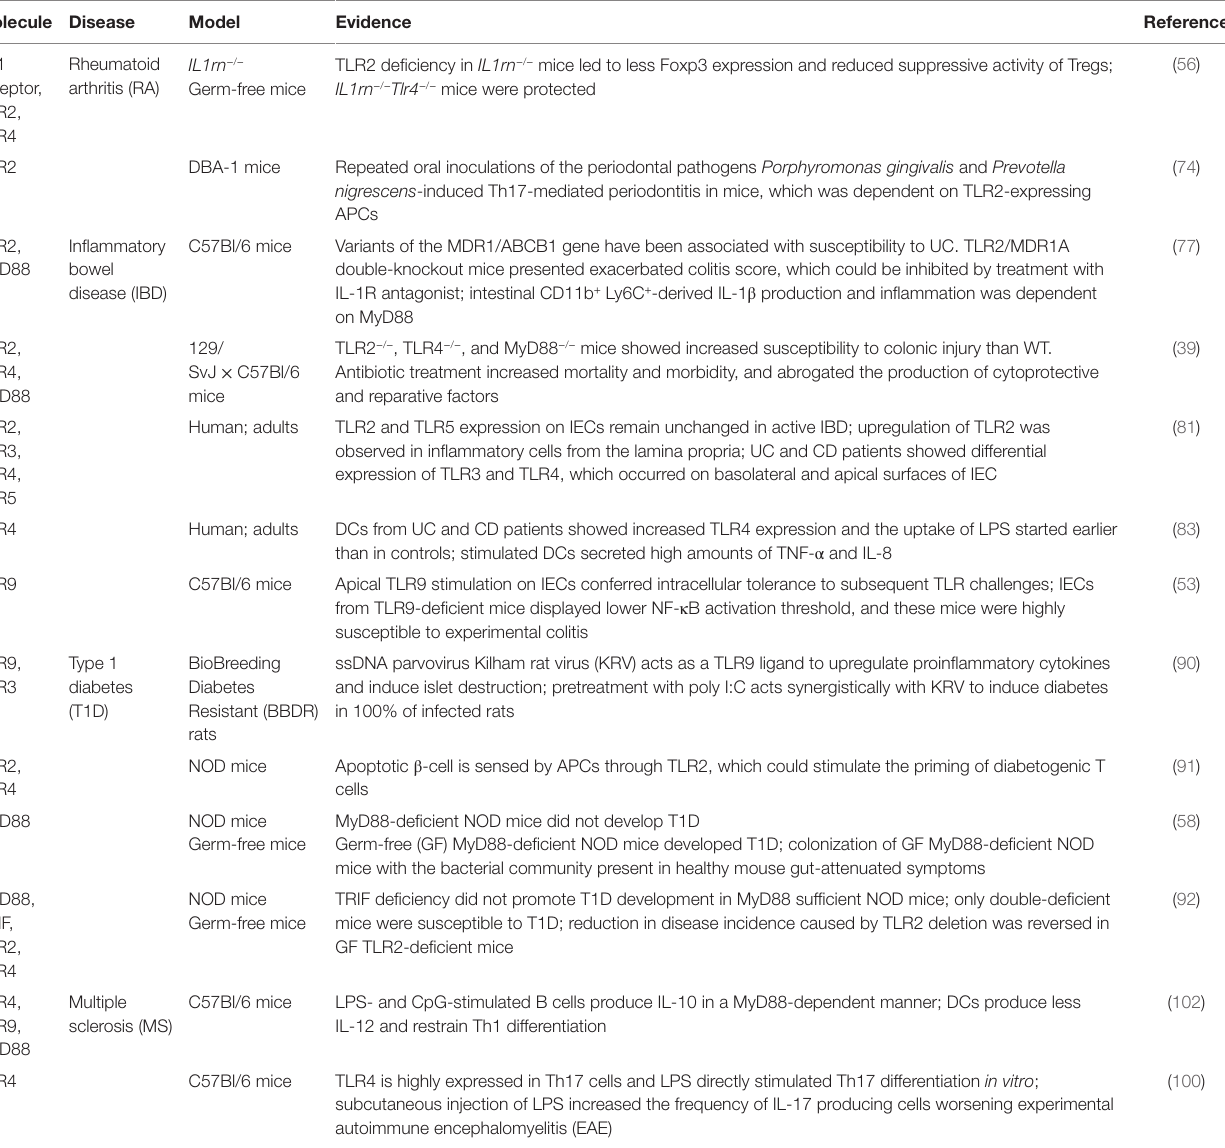
TABLe 1 | Toll-like receptors and related molecules involved in inflammatory and autoimmune diseases. Molecule